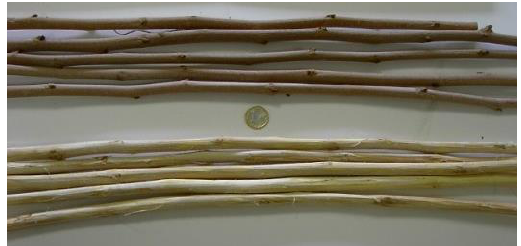
Figure 1. Mulberry branches obtained from pruning operations.